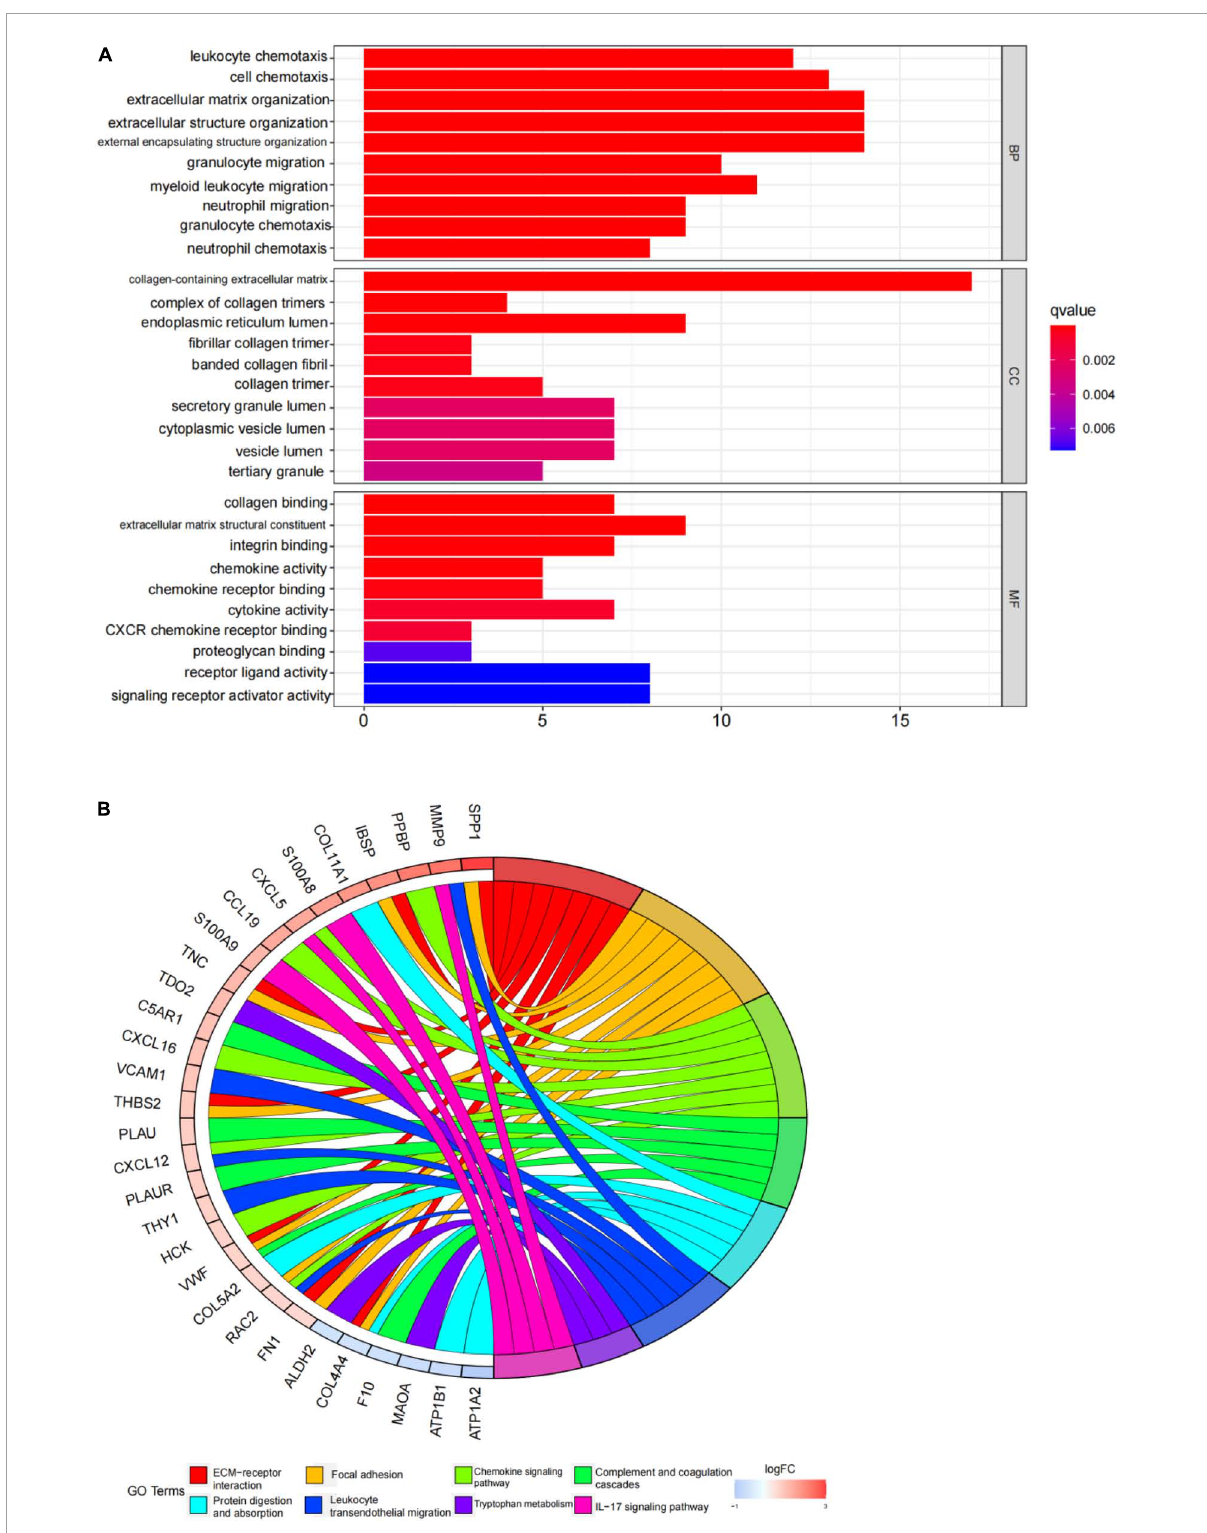
FIGURE4 Gene ontology (GO) and kyoto encyclopedia of genes and genomes (KEGG) enrichment analysis results. (A) The top 10 items from the GO pathway enrichment studies are shown in the form of a bar plot. Statistical significance was defined as a P -value < 0.05. BP denotes biological processes; CC denotes cellular components, and MF denotes molecular function. (B) The top eight terms from the KEGG pathway enrichment studies are shown in the form of a circle plot. A p -value < 0.05 was considered statistically